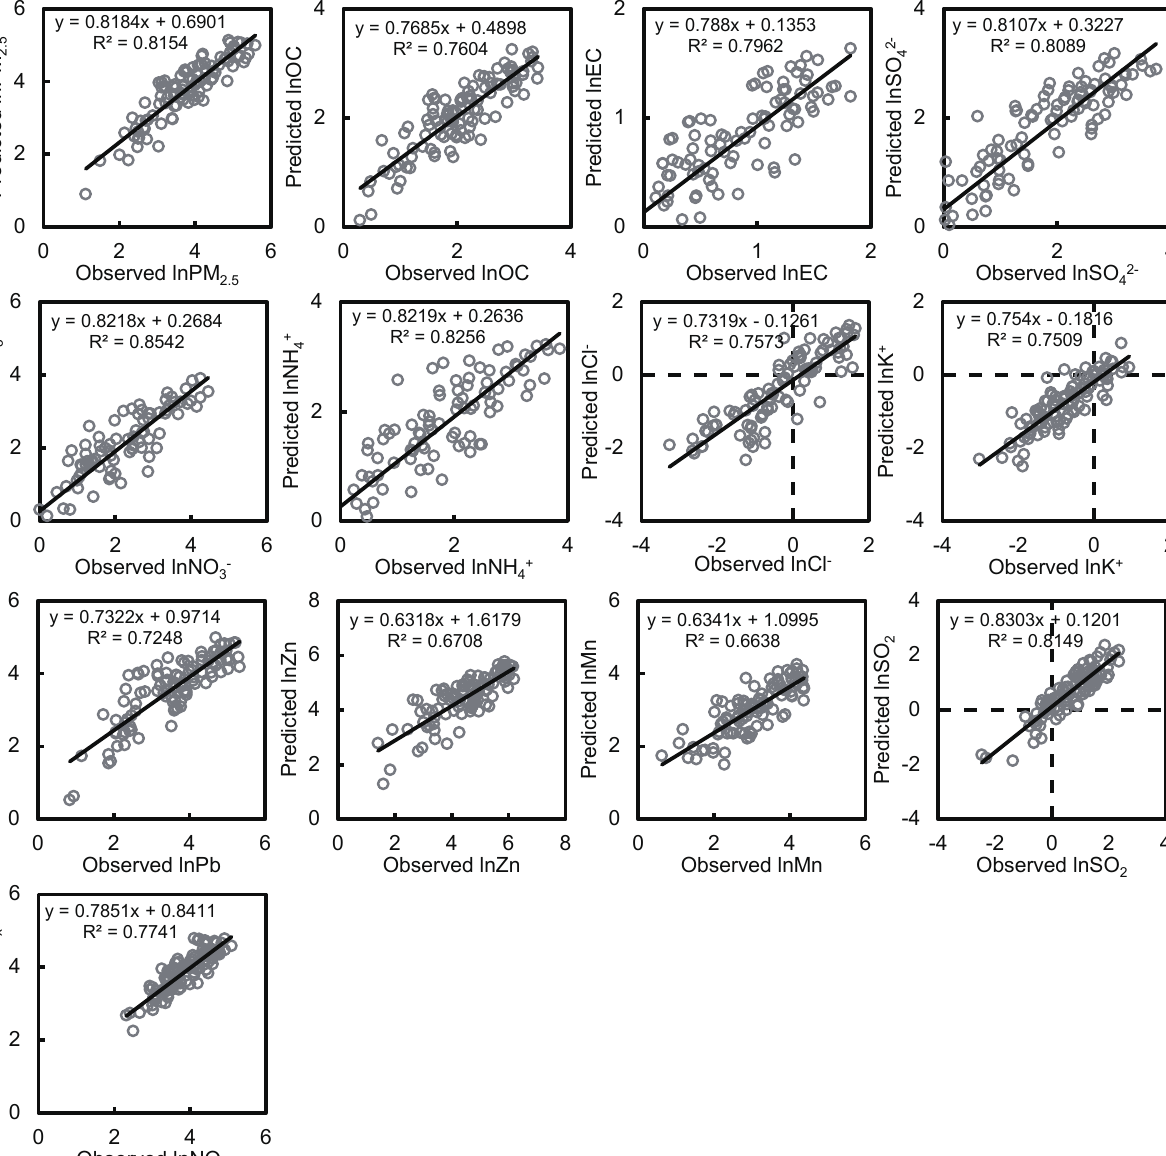
Figure 7. Scatter plot and correlations between GLM-predicted ( y axis) and observed ( x axis) concentrations of pollutants transformed to a natural log. The linear regression equations and R 2 values are